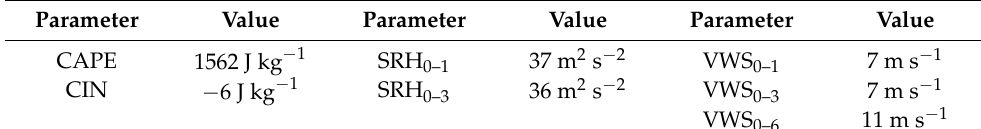
Table 2. The storm environmental factors based on the NJ sounding, including the convective available potential energy (CAPE), the convective inhibition (CIN), the 0–1 (SRH 0–1 ) and 0–3 (SRH 0–3 ) km storm-relative helicity, and the 0–1 (VWS 0–1 ), 0–3 (VWS 0–3 ), and 0–6 (VWS 0–6 ) km vertical wind shear.